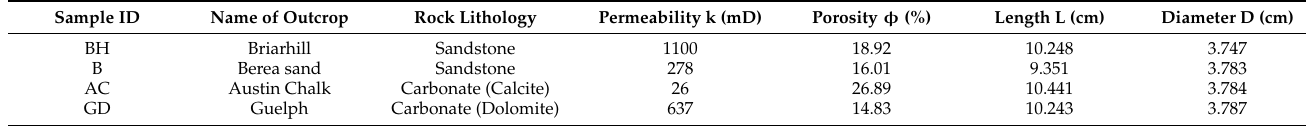
Table 1. Core samples properties and dimensions.